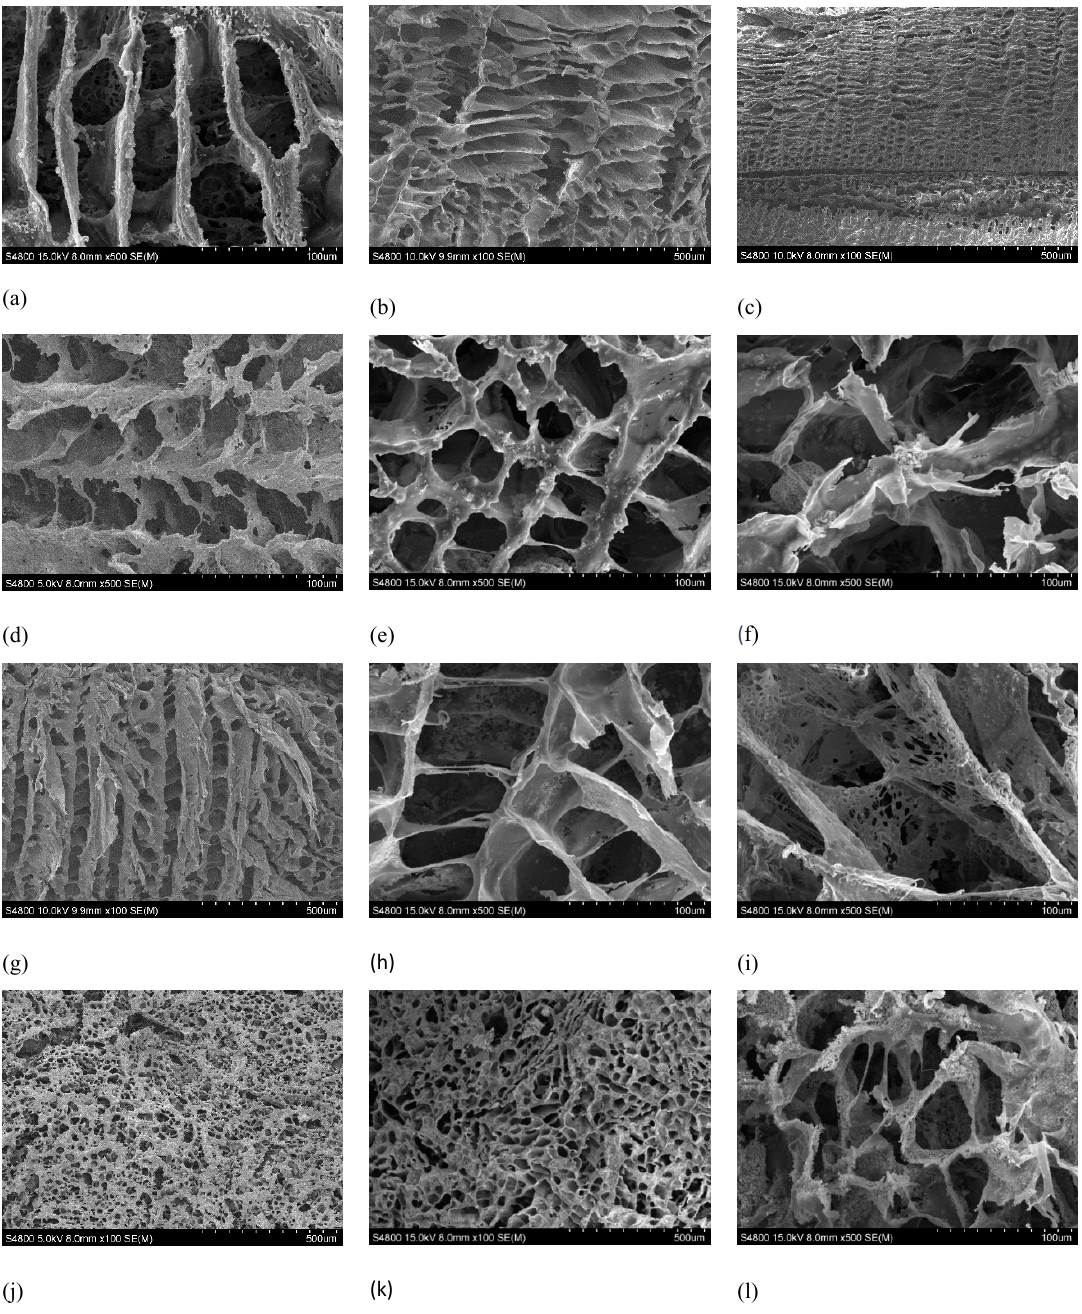
Figure 3. SEM observation of Surface morphology of PLLA and PLLA/ nFe 3 O 4 systems. ( a ) PLLA before in vitro degradation. ( b ) PLLA after in vitro degradation for 8 weeks. ( c ) PLLA after in vitro degradation for 25 weeks. ( d ) PLLA30%nFe 3 O 4 before in vitro degradation. ( e ) PLLA30%nFe 3 O 4 after in vitro degradation for 8 weeks. ( f ) PLLA30%nFe 3 O 4 after in vitro degradation for 25 weeks. ( g ) PLLA50%nFe 3 O 4 before in vitro degradation. ( h ) PLLA50%nFe 3 O 4 after in vitro degradation for 8 weeks. ( i ) PLLA50%nFe 3 O 4 after in vitro degradation for 25 weeks. ( j ) PLLA70%nFe 3 O 4 before in vitro degradation. ( k ) PLLA70%nFe 3 O 4 after in vitro degradation for 8 weeks. ( l ) PLLA70%nFe 3 O 4 after in vitro degradation for 25 weeks.